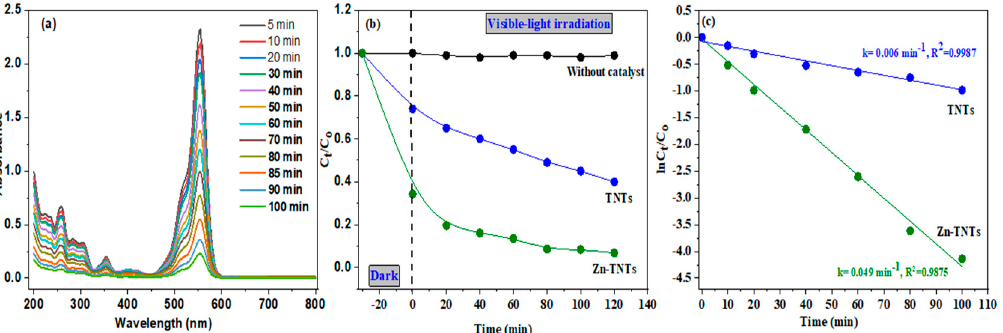
Table 3. Chemical oxygen demand (COD) changes of RhB over the Zn-TNTs at different times.